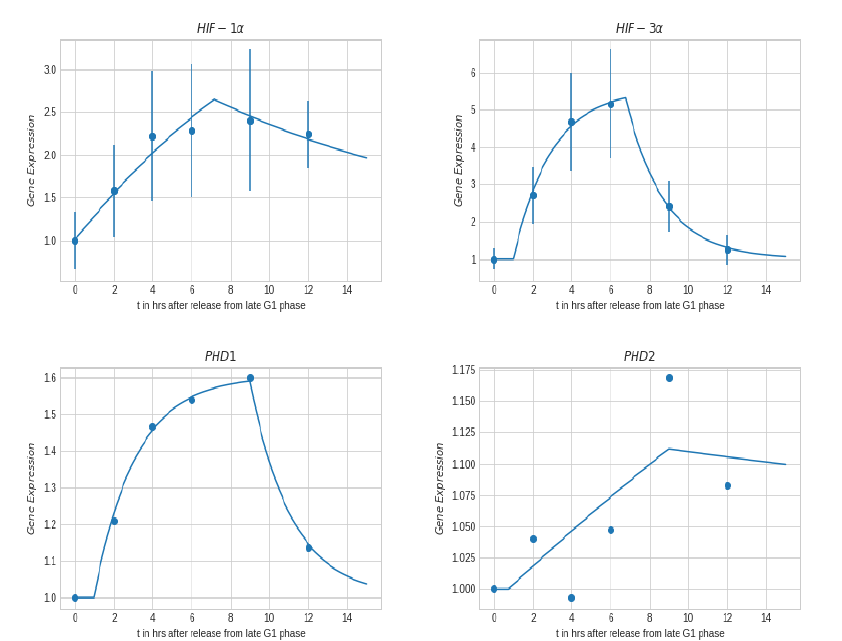
Figure 8. Gene expression obtained with RT-qPCR after release from cell synchronization at G1-/S- phase for bladder cancer cells, T24, for 1% oxygen pressure. (dots are the measured values, lines is best